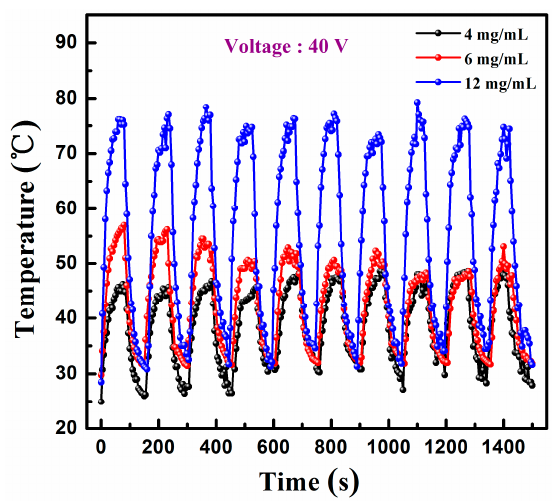
Figure 7. On/off responses of the film heaters with the Ag NW addition of 4, 6, and 12 mg/mL at 40 V after four-month preservation.